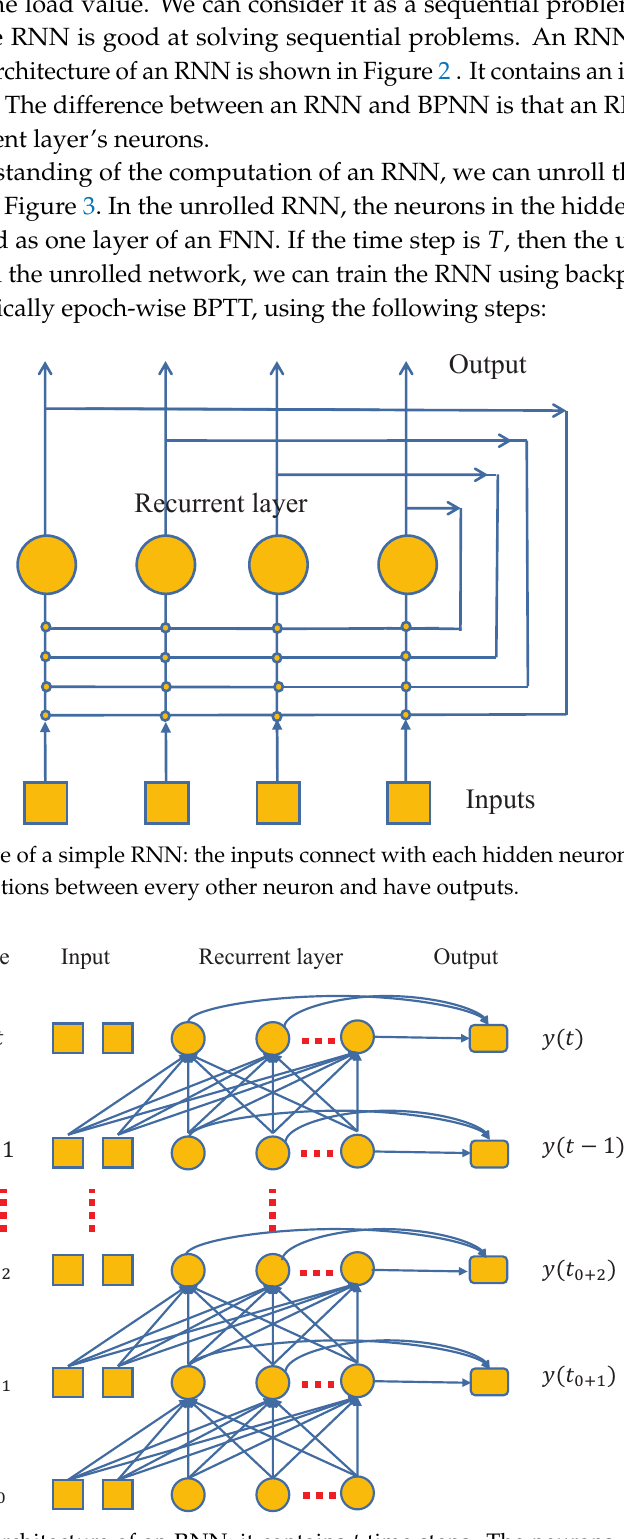
Figure 3. Unrolled architecture of an RNN: it contains t time steps. The neurons at each time step constitute one layer of the unrolled RNN. This unrolled RNN contains t layers, and at each time step t , the output is y ( t )